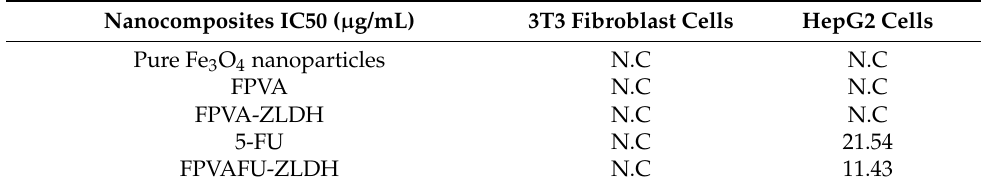
Figure 12. Cytotoxicity assay of pure Fe 3 O 4 nanoparticles, FPVA, FPVA-ZLDH (nanocarriers), pristine 5-FU, and FPVAFU- ZLDH (nanoparticles) against HepG2 cells at 72 h of incubation. Table 6. The half-maximal inhibitory concentration (IC 50 ) value forFe 3 O 4 nanoparticles, FPVA, tested on 3T3 and HepG2 cell